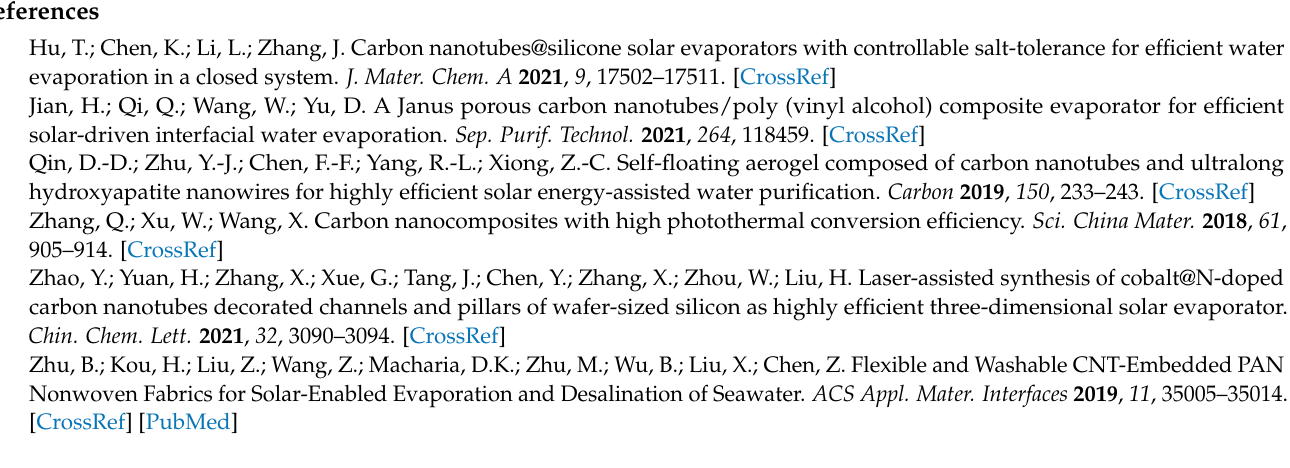
Sample 1 and Sample 2. Figure S2: Influence of the substrate on the temperature